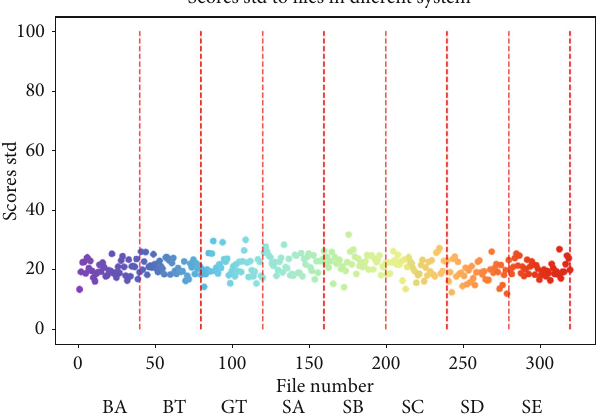
Figure 3: Standard deviation of scores given to all video segments of 8 synthetic system di ff erent color represents the di ff erent fi les, and the subscript of the area separated by the red dotted line represents which system the fi le comes